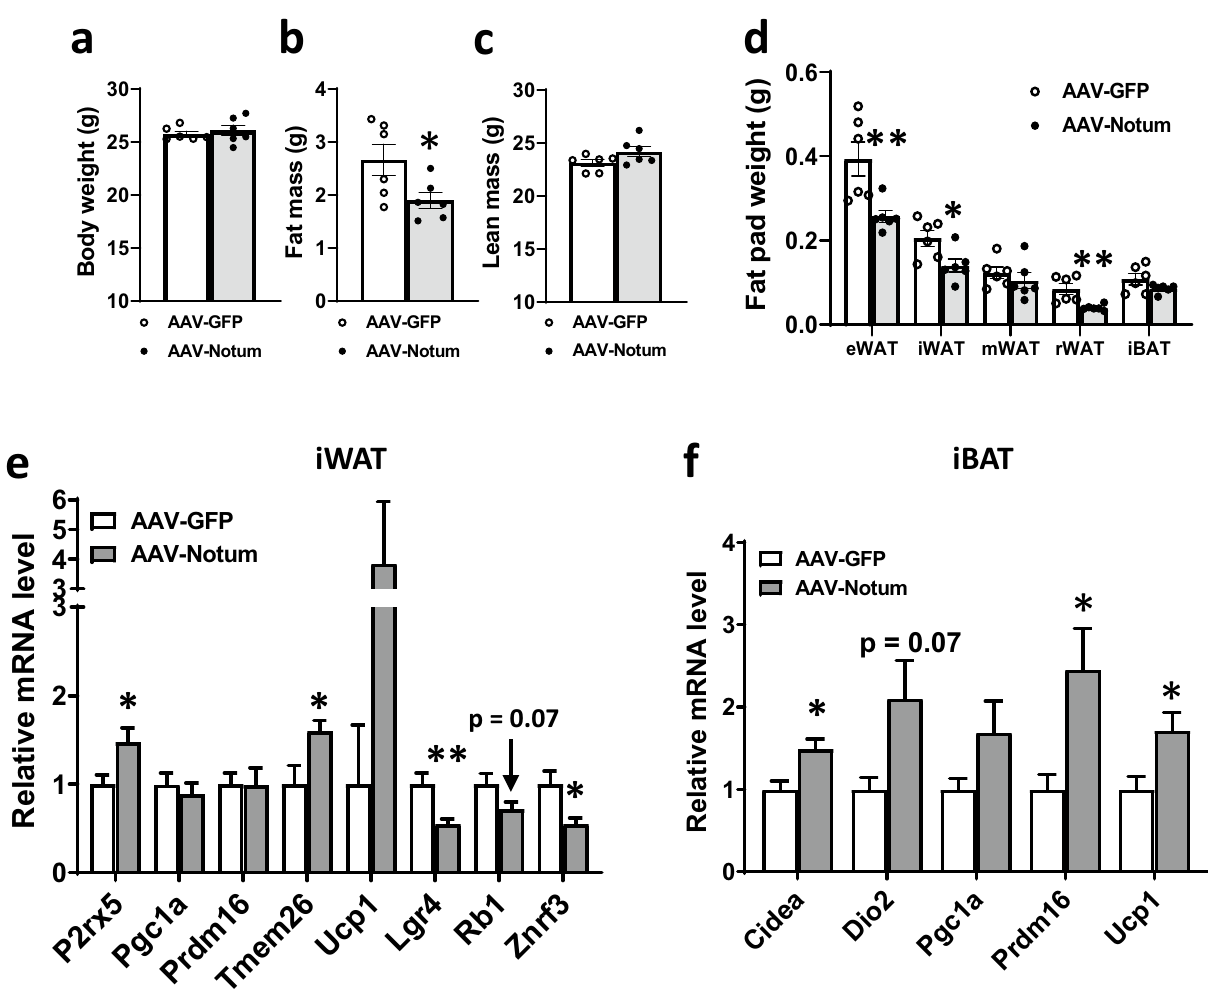
Figure 6. NOTUM overexpression decreases adiposity in chow diet-fed mice. Male C57BL/6J mice were infected with AAV-GFP or AAV-Notum (n = 6 per group) and maintained on a low fat chow diet for 4 weeks before tissue collection. Body weight ( a ), fat mass ( b ), lean mass ( c ), and fat pad weights ( d ) are shown. Gene expression analysis by qPCR of iWAT ( e ), n = 6, and iBAT ( f ), n = 4–5, are shown. Symbols are the same as shown in Fig. 1.